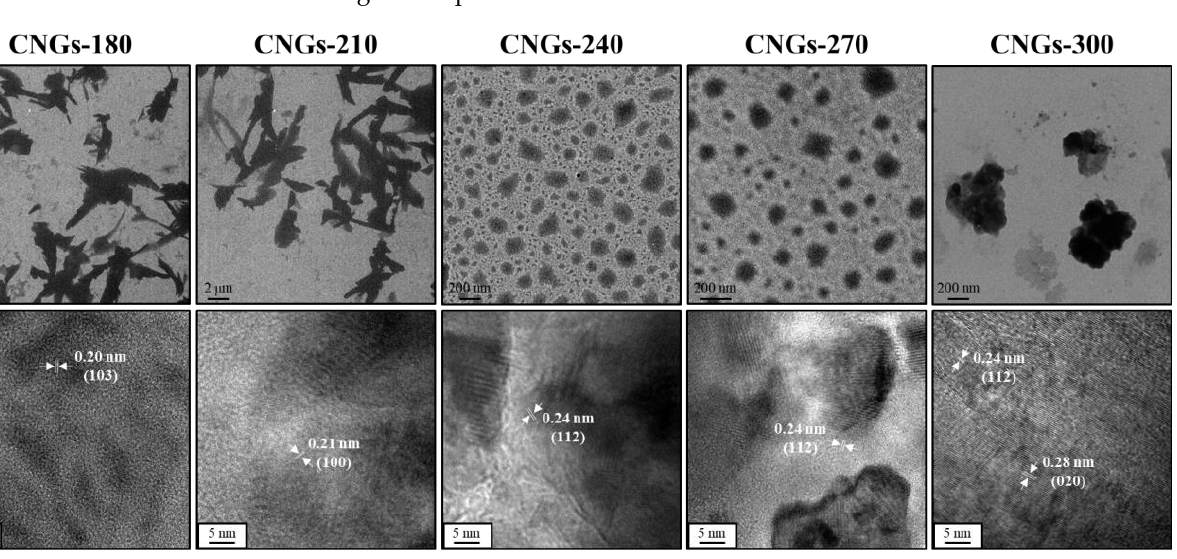
Figure 1. ( A ) TEM and ( B ) HRTEM images of CNGs synthesized at 180 °C – 300 °C. The CNGs exhibited ζ -potential values from ca. +10 to +25 mV (Table S1), as a result of the preservation of high amine content during dehydration, condensation, and carbonization of the carboxylic acid group, α -amino group, amino group on the side chain, and the alkyl group. The pyrolyzed lysine probably forms pyridine, lactams, piperidines, pyrroles, amides, tertiary amine, hexamethyleneimine, and cyclohexanone residues, which are incorporated into the CNGs [29]. The UV-visible absorption spectra of CNGs showed a strong absorption band at 270–290 nm due to the π → π * transitions of conjugated C=C bonds (Figure S2) [30]. A shoulder band at 310–350 nm is ascribed to the n → π * surface and edge defect transitions of CNGs with C=O bonds, C=N bonds, or the interlayer π → π * charge transfer, revealing oxygen- and nitrogen-containing functional groups in the CNGs [30]. Upon excitation at 365 nm, the CNGs emitted a strong and broad fluorescence band centered at a wavelength of ca. 450 nm. Nitrogen-doped CNGs usually exhibit strong fluorescence, which could be attributed to the formation of diverse sizes of polycyclic aromatic clusters, edge defects, surface emissive traps, and restriction of the intramolec- ular vibrations and rotations, thereby minimizing the internal non-radiative relaxation pathways [31]. The fluorescence quantum yields (QYs) of the CNGs are presented in Table S1, which shows that CNGs-300 had the highest QY (17.3%) of all, probably due to it having the highest degree of carbonization. The elemental composition (C, H, O, N, and Cl) of the CNGs, presented in Table S2, shows that the carbon content (40.1–60.3%) of the CNGs increased with increasing temperature, indicating a carbonization process at high temperatures. In contrast, the oxygen (9.3–23.7%) content of the CNGs showed an opposite trend with increasing temperature, due to the oxygen loss during the dry-heating process. Notably, CNGs-270 showed the highest nitrogen content (16.6%), implying the formation of more pyridine-like structures at 270 ◦ C [32]. The X-ray diffraction (XRD) patterns of lysine, purified CNGs-180, and CNGs-210 showed some sharp peaks and a broad-band at ca. 18–33 ◦ , which could be ascribed to the characteristic peaks of molecular lysine crystals (Figure S3) [33]. The characteristic diffraction peak gradually